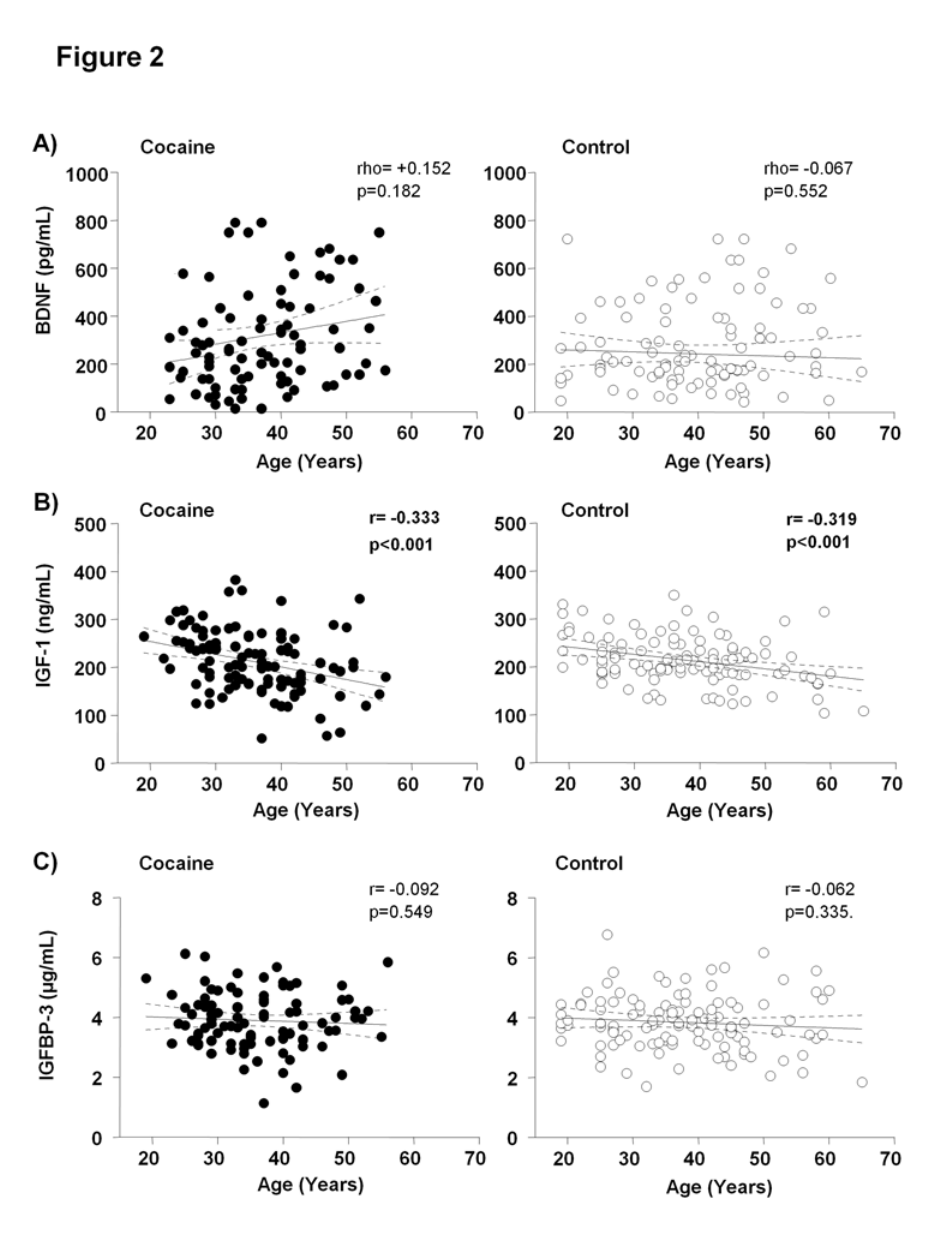
Fig 2. Correlation analyses between plasma concentrations of BDNF, IGF-1 and IGFBP-3 and age in abstinent cocaine users (black circles) and control subjects (white circles). A) BDNF (pg/mL); B) IGF-1 (ng/mL); and C) IGFBP-3 ( μ g/mL). Dots are individual values. (r) Pearson´s correlation coefficient; (rho) Spearman´s correlation coefficient; (p) p-value for statistical